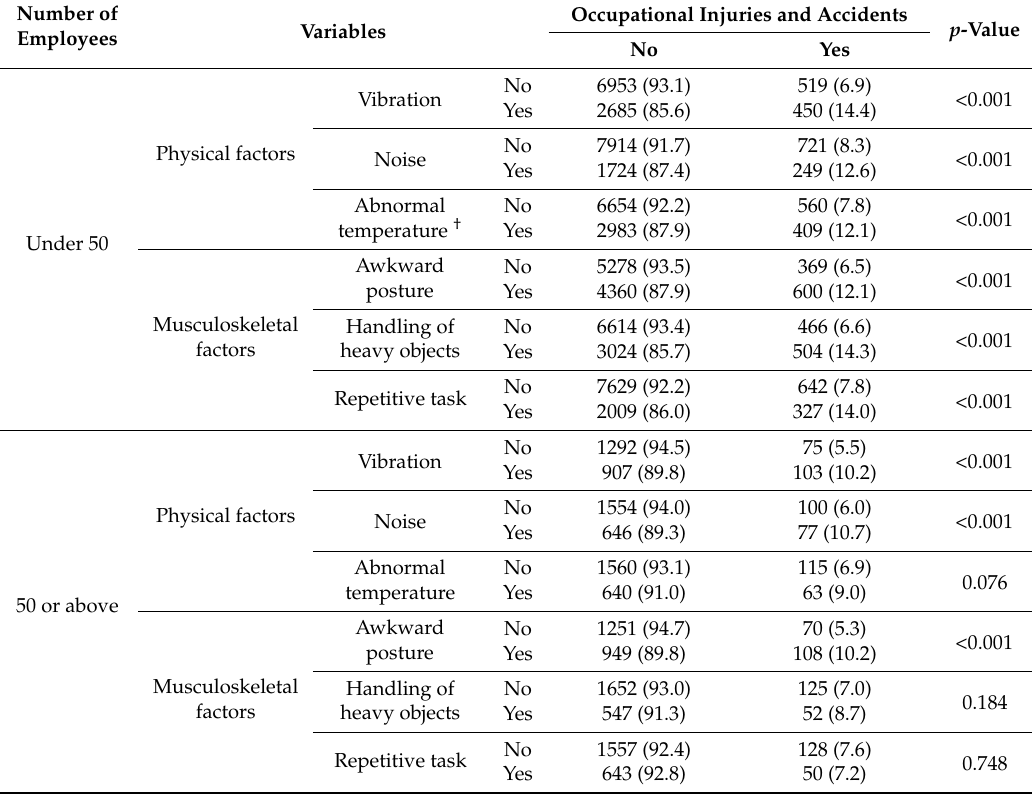
Table 3. Differences in the prevalence of occupational injuries and accidents in workplaces of different sizes based on physical and musculoskeletal